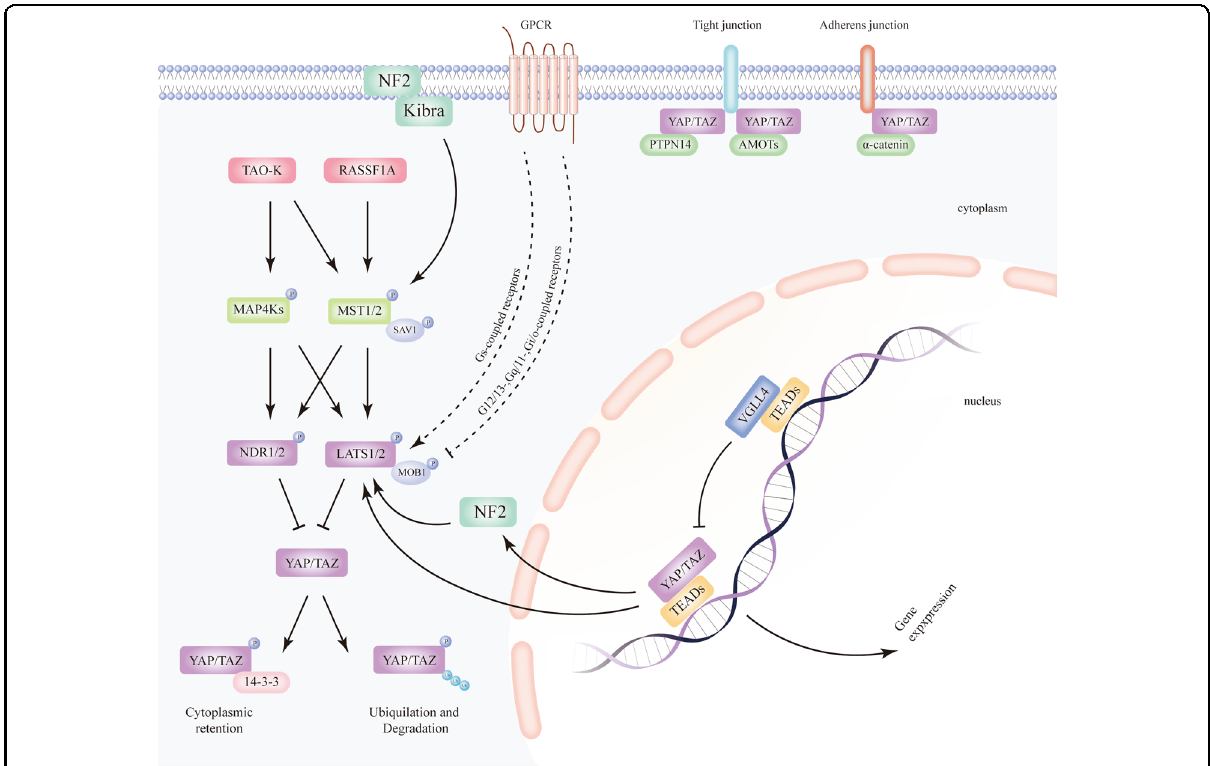
Fig. 1 Regulation of the mammalian Hippo pathway. The core components of the Hippo pathway encompass MST1/2 and LATS1/2, whereas YAP/TAZ are two major effectors of this pathway. Traditionally, upstream signals turn on the Hippo pathway by phosphorylating and activating MST1/2 as well as the scaffold protein SAV1, followed by phosphorylation and activation of LATS1/2 and the scaffold protein MOB1, thereby preventing YAP/TAZ from translocating to the nucleus and initiating gene expression via binding to TEADs. VGLL4, a transcriptional co-repressor, competes with YAP/TAZ for TEADs binding. Instead, phosphorylated YAP/TAZ are isolated in the cytoplasm through interaction with protein 14-3-3 or experience ubiquitylation and degradation. Expanded Hippo pathway encompasses MAP4Ks as well as NDR1/2. MAP4Ks function similarly as MST1/2, performing activating phosphorylation of LATS1/2 and/or NDR1/2, consequently leading to the inhibition of downstream YAP/TAZ via LATS1/2- or NDR1/2-regulated phosphorylation. The complex of YAP/TAZ and TEADs can both directly enhance the function of LATS2 and indirectly stimulate LATS1/2 expression via NF2, which constitute a feedback loop. Independent of the upstream kinases, YAP/TAZ may be directly sequestered at cell junctions via interacting with PTPN14, AMOTs, and α -catenin. NF2, Kibra, RASSF1A, and TAO-K stimulated by upstream stimuli, may phosphorylate and activate MST1/2 and/or MAP4Ks. GPCRs may inhibit and enhance LATS1/2 depending on the types of receptors. Arrows, blunt ends, and dotted lines indicate activation, inhibition, and possible regulatory effect, respectively. MST1/2, mammalian sterile 20-like 1/2; SAV1, salvador; LATS1/2, large tumour suppressor homologue 1/2; MOB1A/B, MOB kinase activator 1A/B; YAP, yes-associated protein; TAZ, transcriptional co-activator with PDZ-binding motif; NF2, neuro fi bromin2/Merlin; TAO-K, thousand and one amino acid protein kinase; MAP4Ks, mitogen-activated protein kinase kinase kinase kinase; TEAD, transcriptional enhancer associated domain; VGLL4, vestigial-like family member 4; PTPN14, protein tyrosine phosphatase non-receptor type 14; AMOT,